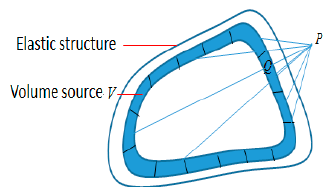
Figure 1. Schematic diagram of wave superposition theory.